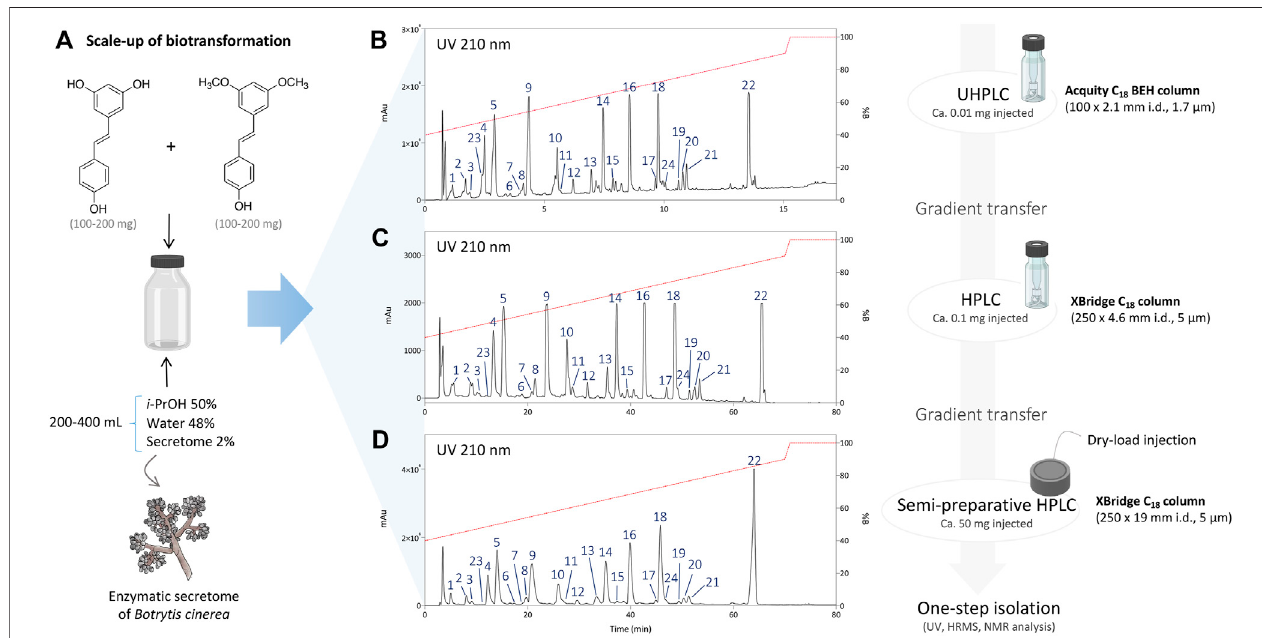
FIGURE 2 | (A) Scale-up conditions of the biotransformation reaction of resveratrol and pterostilbene with the secretome of Botrytis cinerea with 50% of i -PrOH, 2% of enzymatic secretome and 48% of water (total volume 200 – 400 ml). (B) Metabolite pro fi le of the reaction after 24 h using UHPLC-PDA with optimized chromatographic conditions. (C) Analytical HPLC-PDA chromatogram after gradient transfer of the UHPLC-optimized conditions. (D) Semi-preparative HPLC-PDA chromatogram after gradient transfer of the UHPLC-optimized conditions.